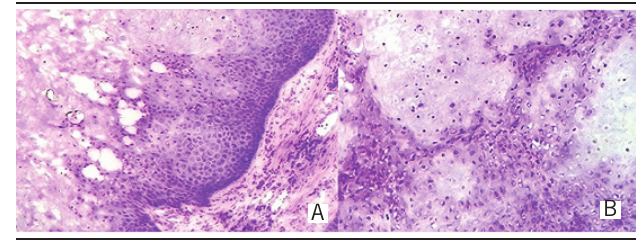
figurE 3 − Intraoperative